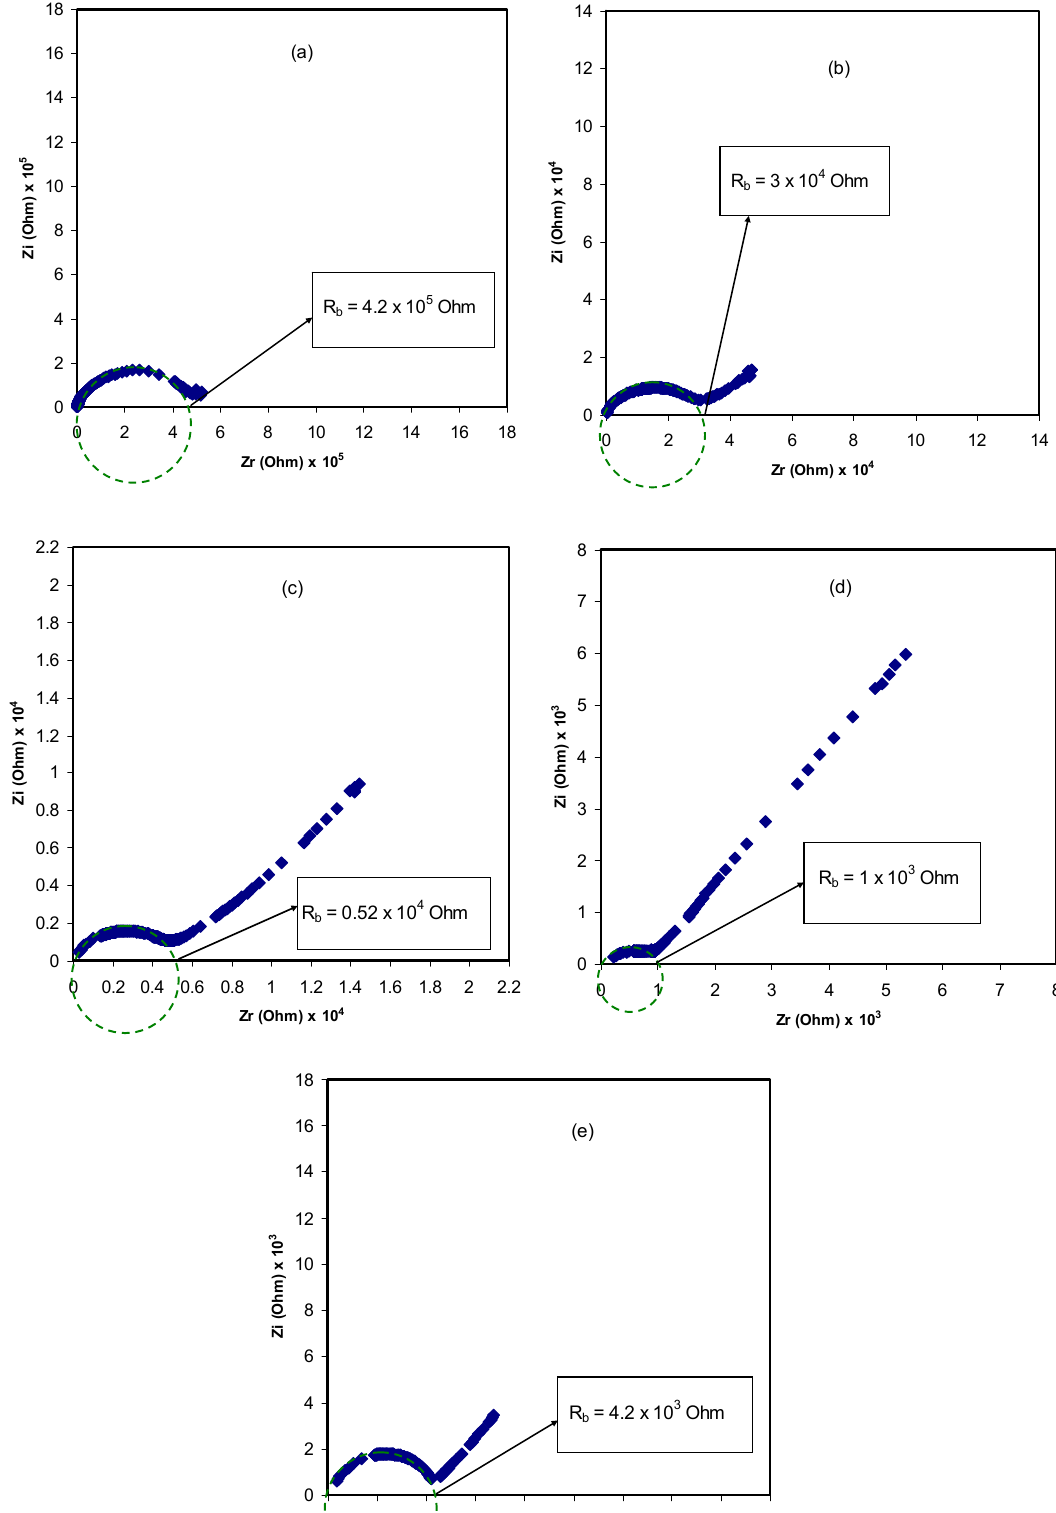
Figure 3. Impedance plot ( Z i versus Z r ) of blended solid polymer electrolytes at room temperature for ( a ) PCSH1, ( b ) PCSH2, ( c ) PCSH3, ( d ) PCSH4, and ( e ) PCSH5.